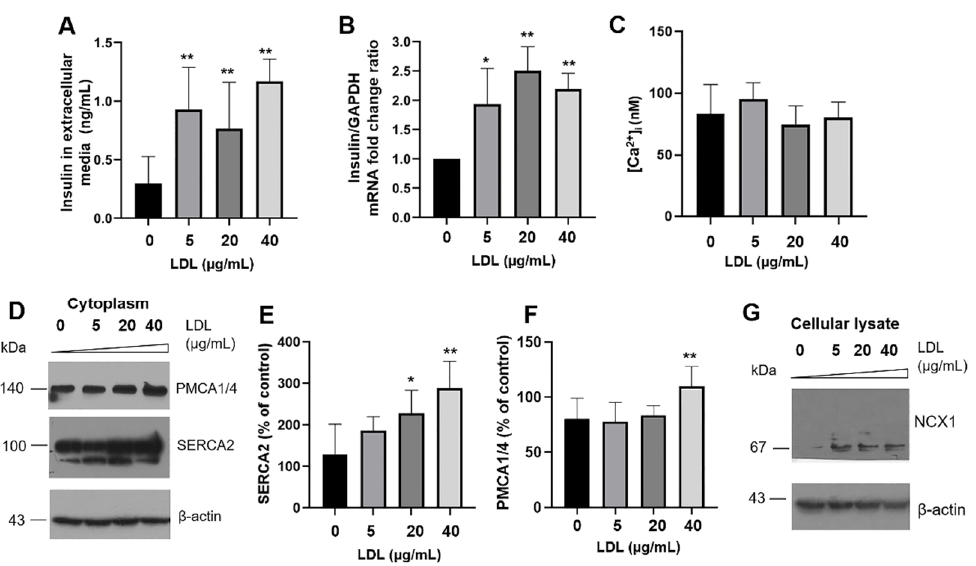
Figure 2. Insulin secretion promoted by LDL is associated with the modulation of targets controlling intracellular calcium levels. ( A ) Effect of LDL treatments (0–40 µg/mL) on insulin secretion ( n = 3, mean ± SD), ** p < 0.005. ( B ) Evaluation of insulin mRNA expression under the same LDL concentrations and 20 h of treatment, qPCR reactions were performed for triplicate, and GAPDH was used as a reference calibrator. Results are reported as mean ± SD ( n = 3), * p < 0.05, ** p < 0.005. ( C ) Quantification of intracellular Ca 2+ . ( D ) Expression of PMCA1/4 and SERCA2 on cytoplasm lysates, representative Western blots are showed; quantitative characterization of the ( E ) SERCA2 and ( F ) PMCA1/4 expression ( n = 3, mean ± SD), * p < 0.05, ** p < 0.005. ( G ) Western blot of NCX1 in cellular lysates; β-actin was used as a loading control.